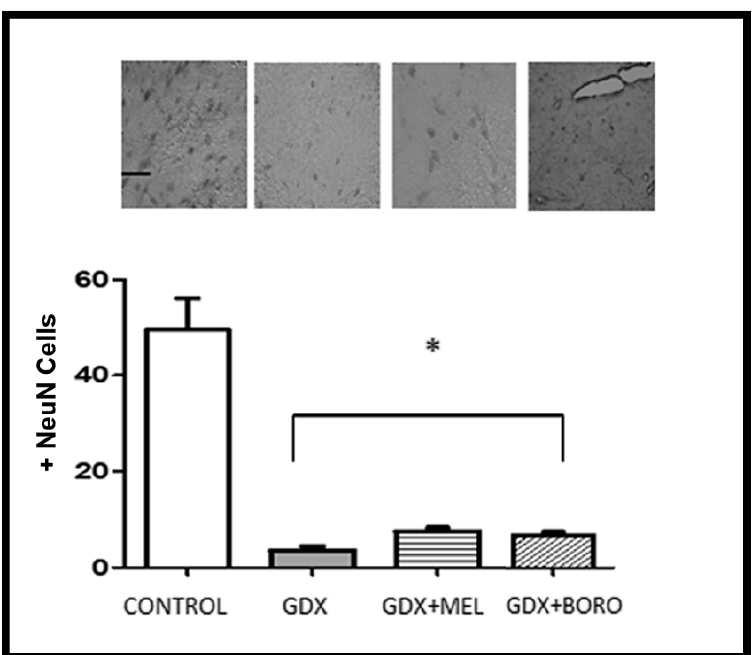
Figure 10. Neuronal survival. Above are photomicrographs of NeuN positive labeling observed in the hippocampus. Magnification 40×. Scale bar represents 100 μ m. In the plot the columns represent the number of NeuN-positive neurons, bars represent SEM. Significant differences in groups com- pared with the control group ( n = 4, * p < 0.01); GDX, gonadectomized; MEL, melatonin; BORO, Borolatonin.